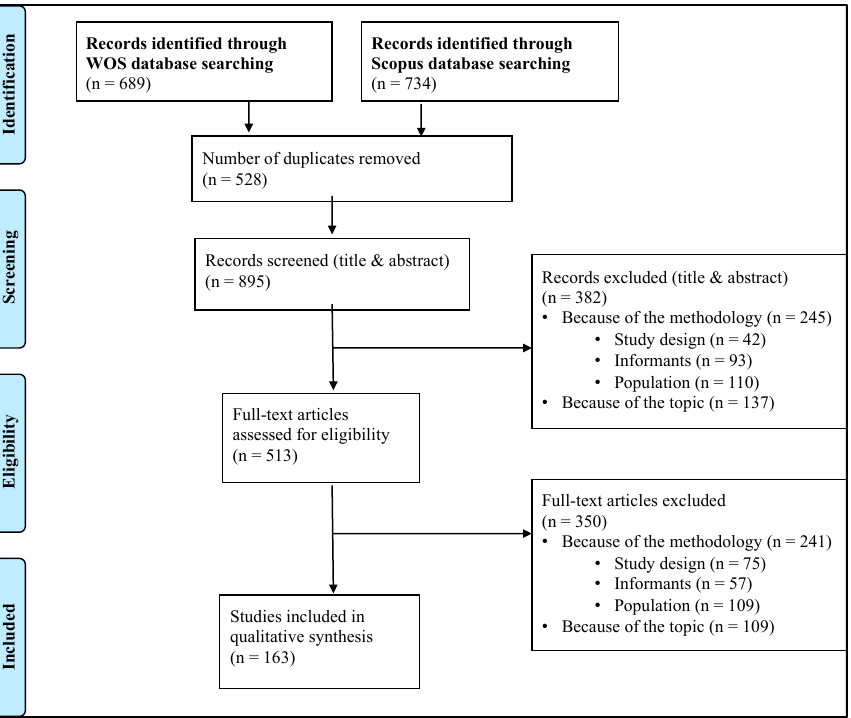
Figure 1. Phases of the systematic review (diagram based on the PRISMA statement [38]).